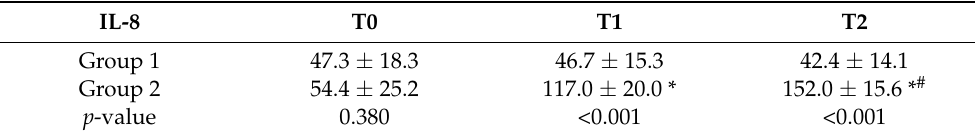
Table 5. IL-8 modulation in HIV+ patients at T0 (basal levels); T1 (after 4 weeks of supplementation), and T2 (after 8 weeks of supplementation and 4 weeks post-immunization). Data are reported as mean ± SD. p -values derived from the contrasts’ analyses are shown in italics. * indicates the statistically significant difference with respect to the basal time. # indicates the statistically significant difference with respect to the previous observation time.